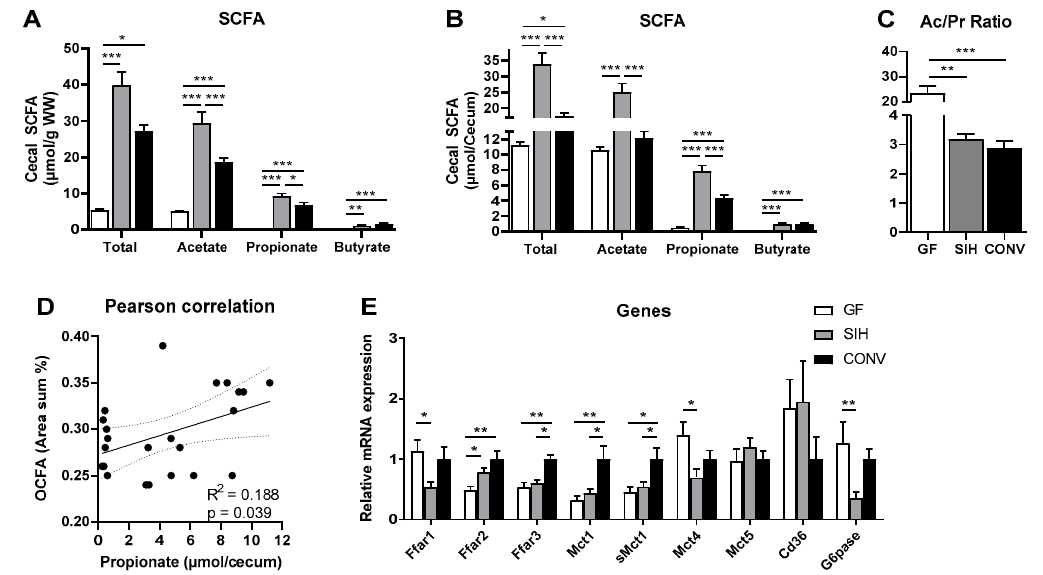
Figure 4. SIHUMI mice (SIH) on a high-fat inulin diet (HFI) display greater cecal acetate and propionate than conventional mice (CONV) and germ-free mice (GF). Sixteen-week-old male C3H/HeOuJ mice on a high-fat inulin diet (HFI, high-fat + 7% inulin): ( A , B ) short-chain fatty acid (SCFA) concentration in cecum and ( C ) the respective acetate/propionate ratio (Ac/Pr). ( D ) Pearson correlation of cecal propionate concentration with hepatic odd-chain fatty acids (OCFA; C15:0 + C17:0) levels is shown. ( E ) mRNA expression of colon mucosa of genes involved in SCFA signaling, transport and intestinal gluconeogenesis. Data are mean + SEM ( n = 6–10) and expression data were normalized to the CONV group. Rpl13a was used as the housekeeping gene. * p < 0.05; ** p < 0.01; *** p < 0.001.